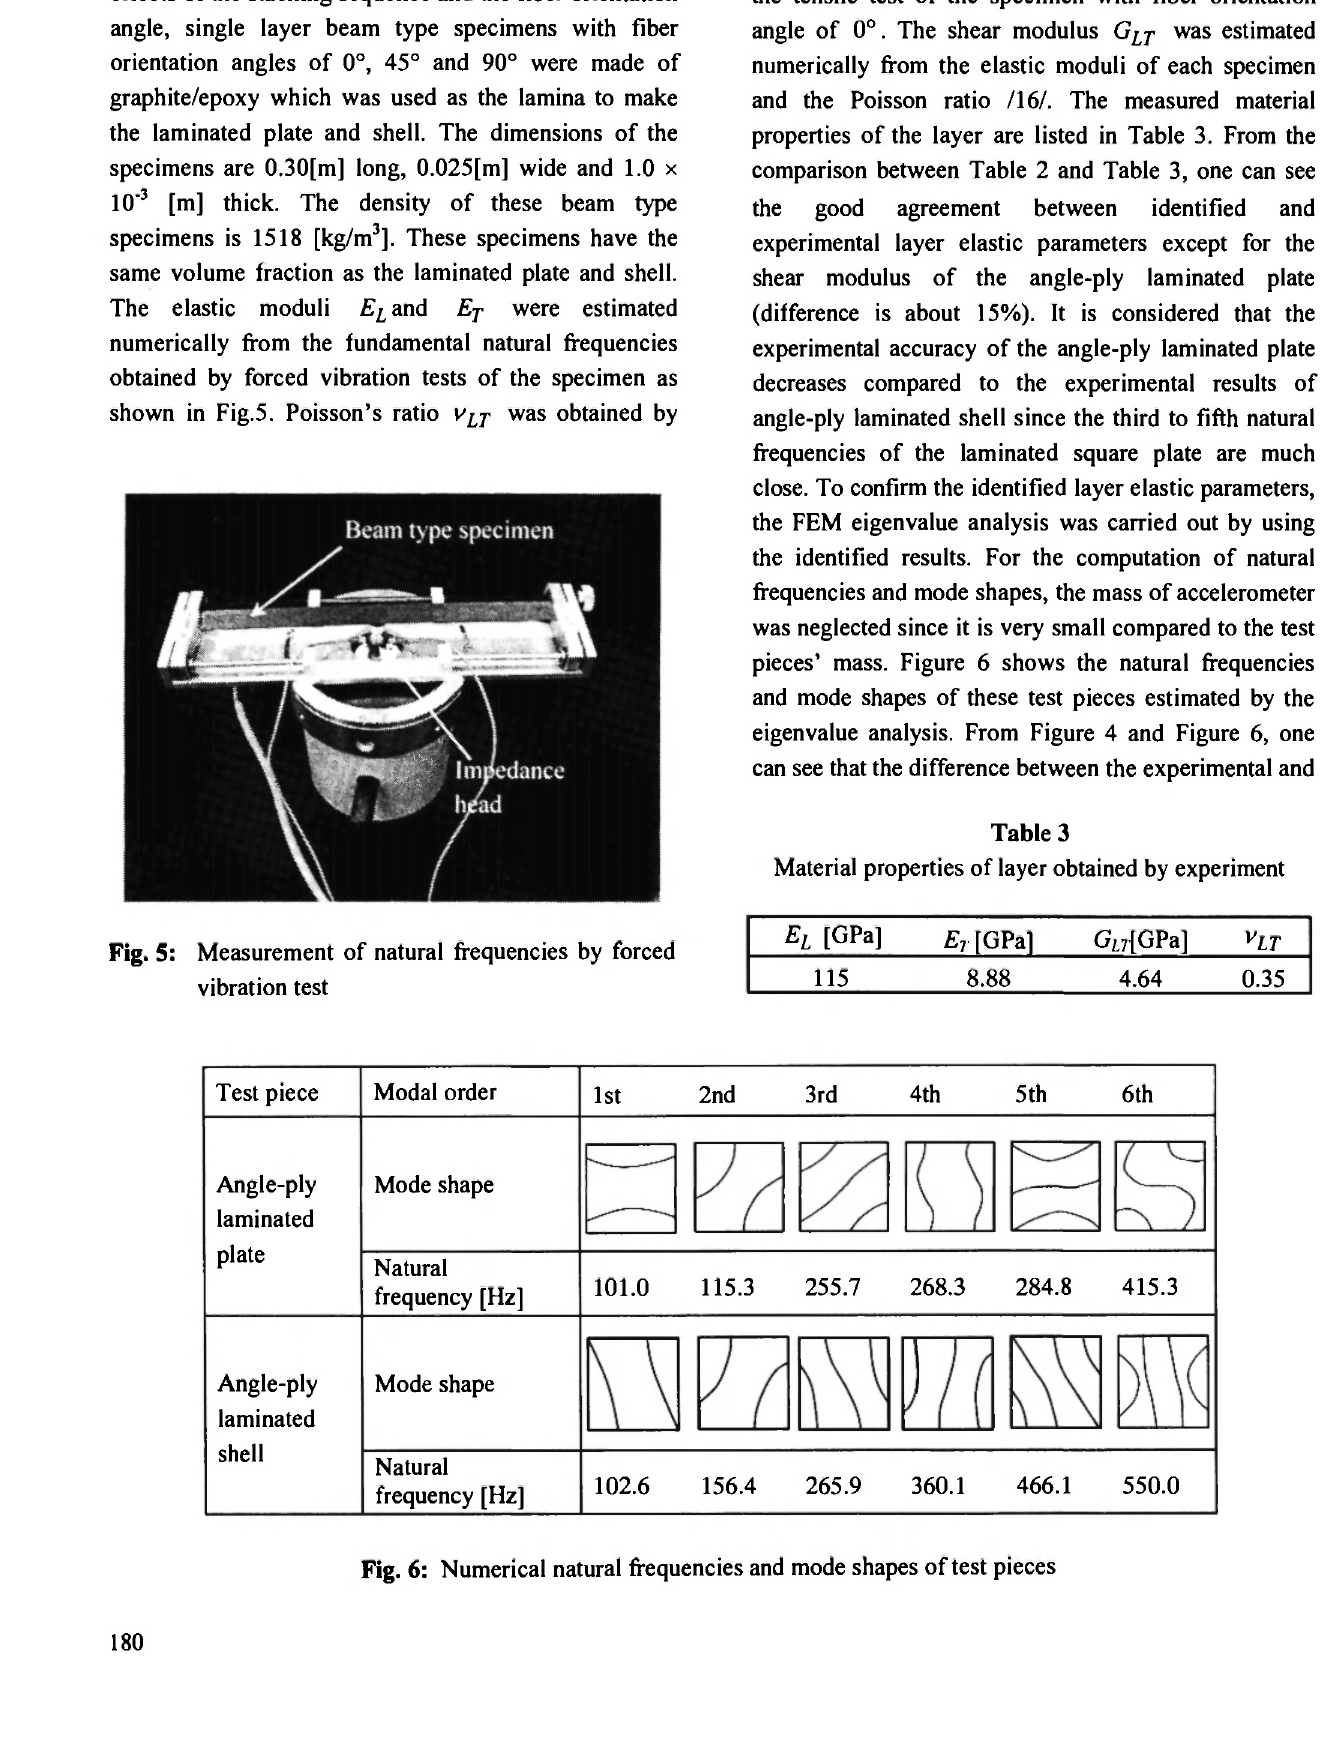
Fig. 6: Numerical natural frequencies and mode shapes of test